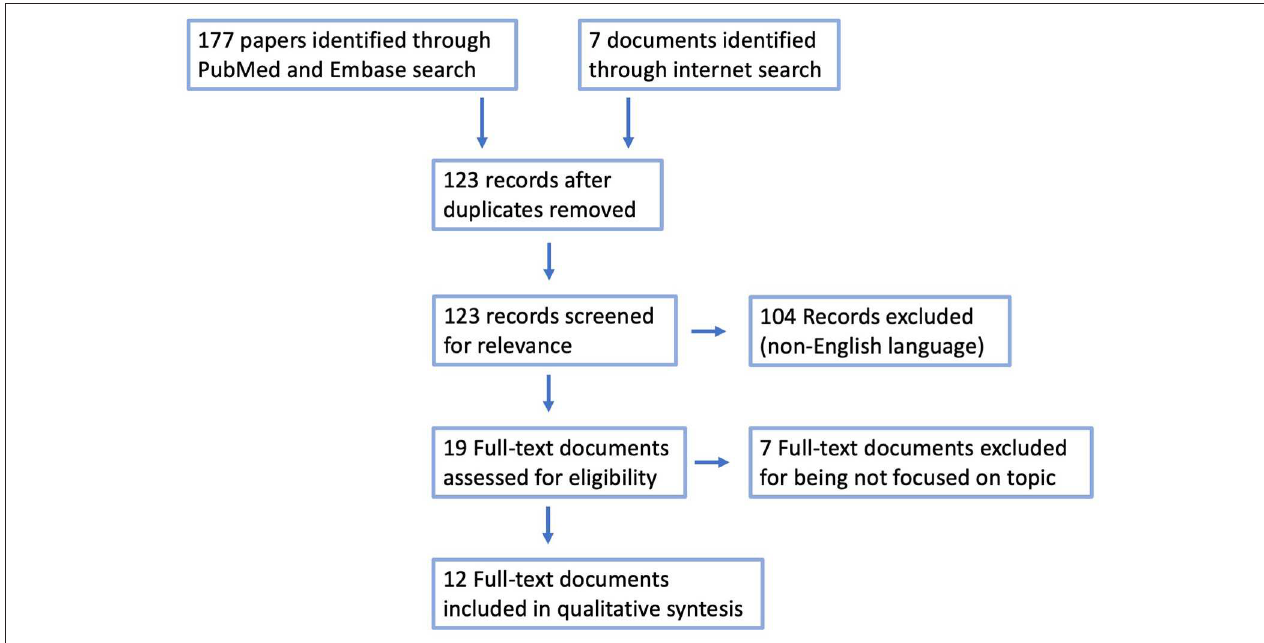
FIGURE 1 | PRISMA module for systematic